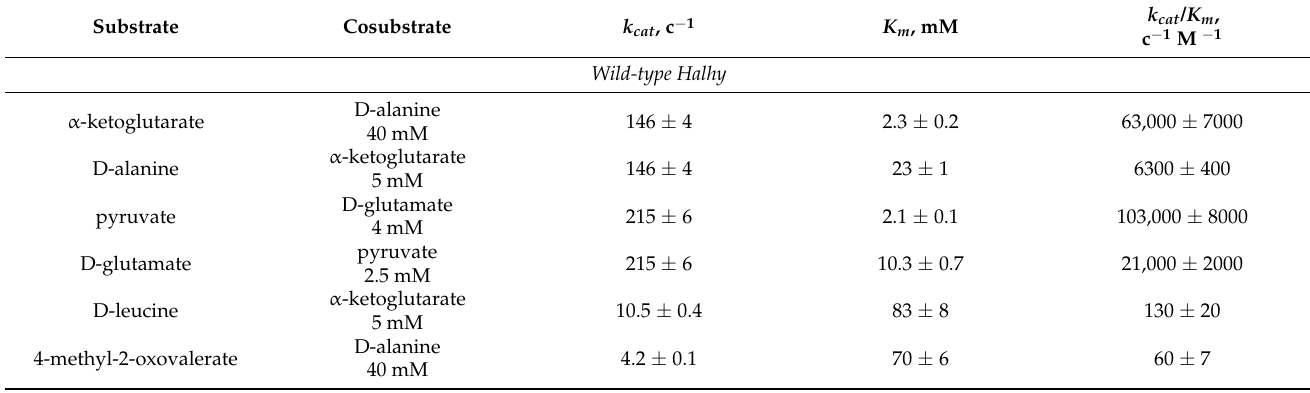
Table 4. The steady-state kinetic parameters of the overall transamination reaction catalyzed by wild-type Halhy (WT) and its R179G